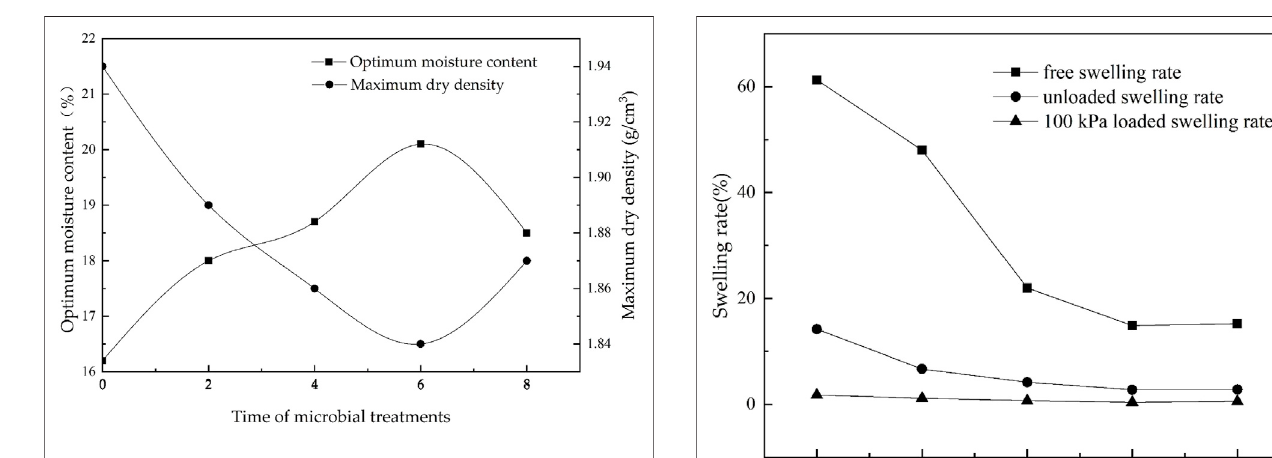
FIGURE 1 | Tested results by compaction test of improved expansive